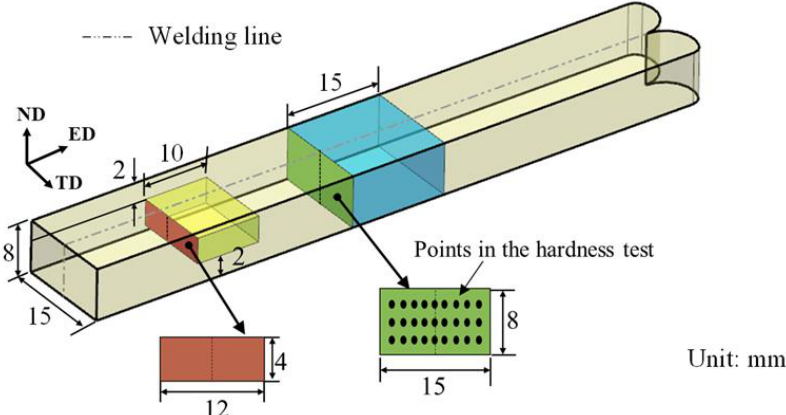
Figure 5. Schematic diagram of the samples used for characterizations.